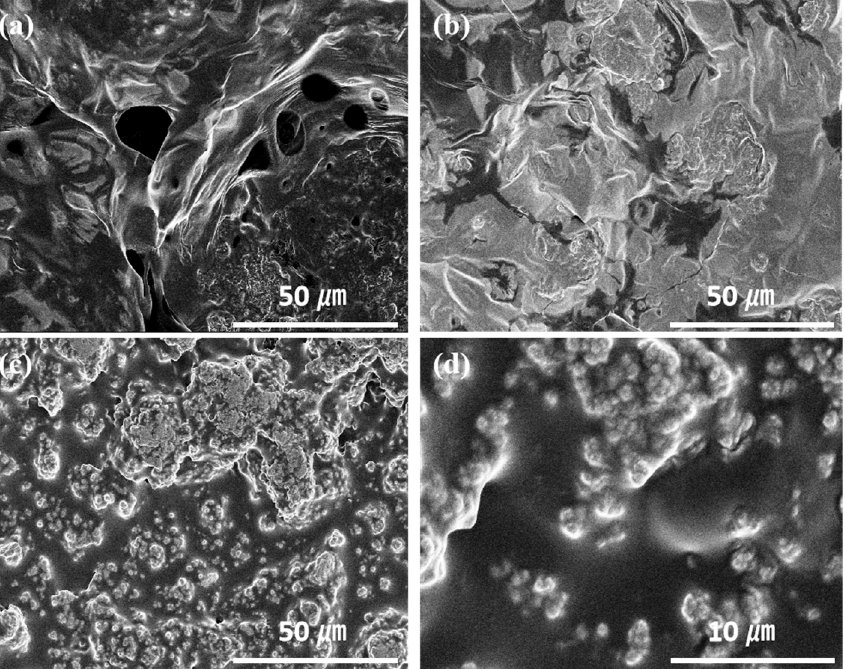
Figure 6. ( a , b ) SEM images of the surface of Si and Si@EG electrodes after the 100th cycle at a current density of 0.1 A g − 1 . ( c , d ) SEM images of the surface of Si@EG@p-PANI electrodes after the 100th cycle at a current density of 0.1 A g − 1 .